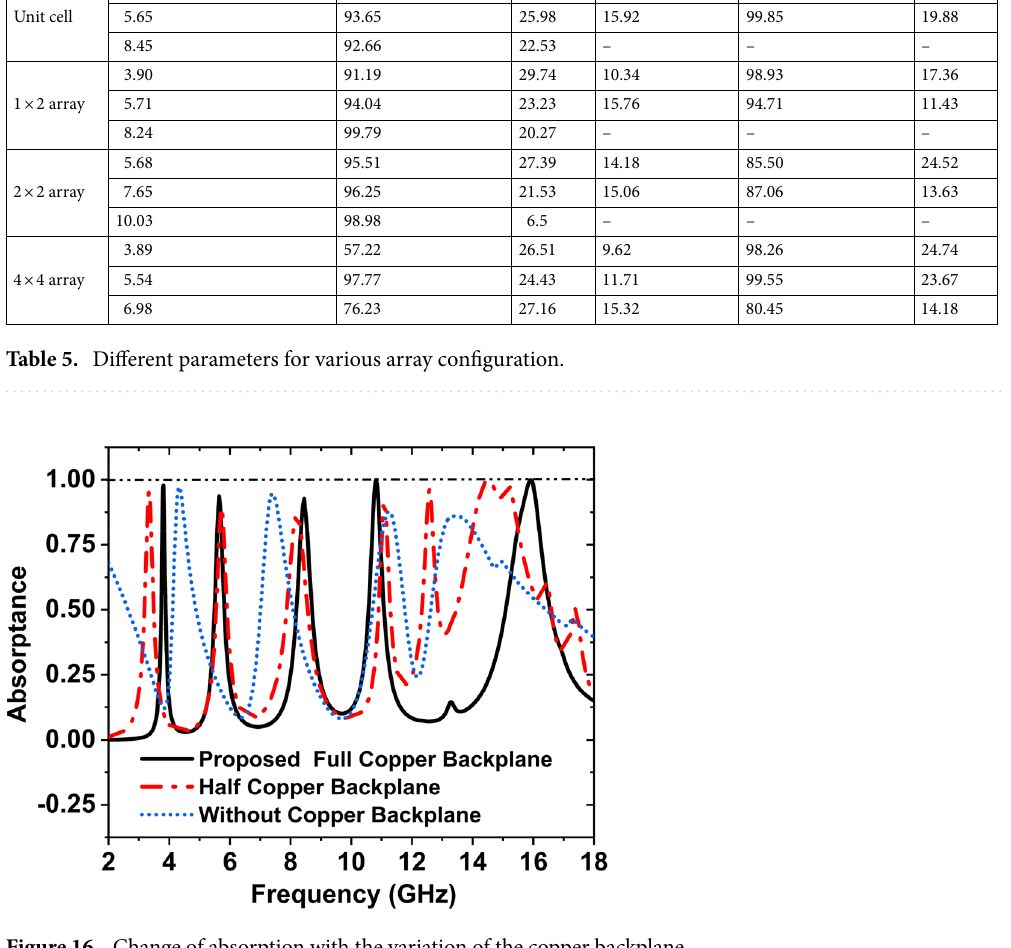
Figure 16. Change of absorption with the variation of the copper